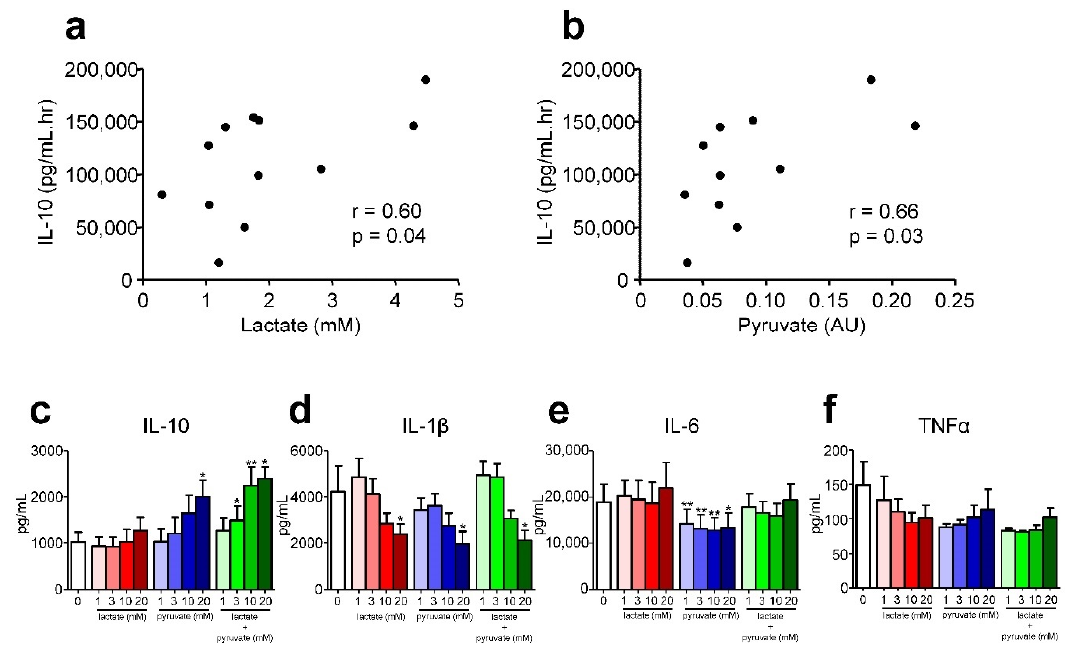
Figure 6. Role of lactate and pyruvate in interleukin (IL)-10 induction. ( a – b ) Relationship between plasma lactate ( a ) and pyruvate ( b ) levels at T = 1 and the plasma IL-10 response (expressed as area under the time-concentration curve (AUC)). ( c – f ) IL-10, IL-1 β , IL-6 and tumor necrosis factor (TNF) α production by LPS-stimulated peripheral blood mononuclear cells (PBMCs) incubated with medium alone (white bar) or different concentrations of lactate (red bars), pyruvate (blue bars), or a combination of the two (green bars). Spearman correlation was used to calculate r and p -values in panels a and b. Data in panels c–f are depicted as mean ± standard error of the mean (SEM) of 6 (panels c–e) or 3 (panel f) donors.* p < 0.05, ** p < 0.01 versus medium control (paired t -tests).